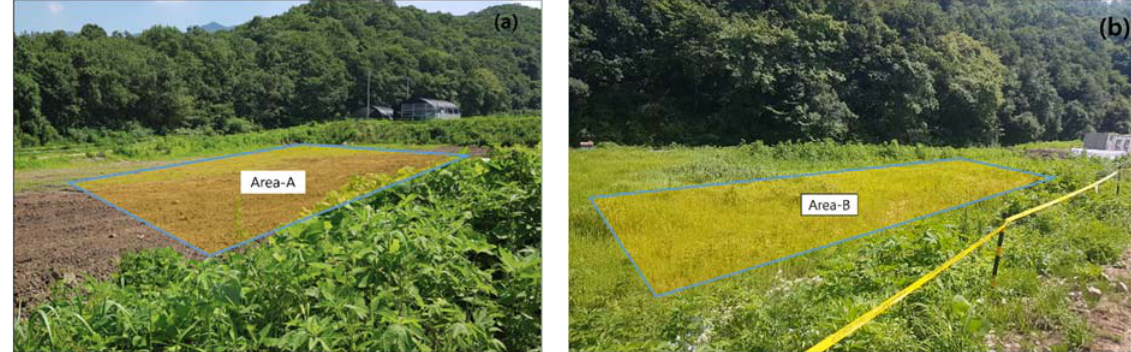
Figure 7. Photograph taken from the southwest of the survey area: ( a ) area where mine removal operations have been completed (30 m × 35 m); ( b ) area scheduled for future mine removal operations (10 m × 50 m).